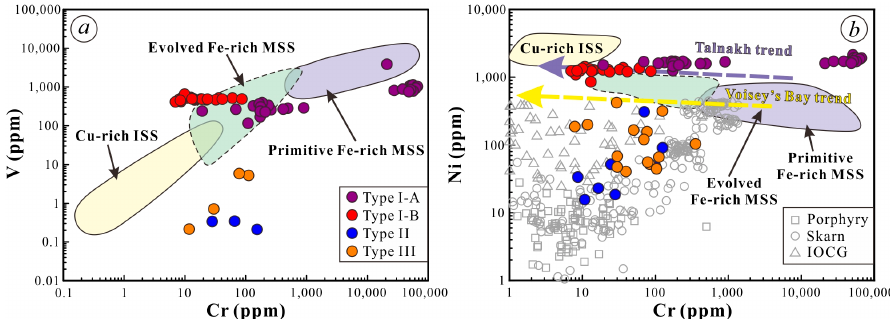
Figure 8. Plots of ( a ) V vs. Cr and ( b ) Ni vs. Cr for the Jinchuan different types of magnetite in massive and disseminated sulfide ores. Fields of primitive Fe-rich MSS, evolved Fe-rich MSS, and Cu-rich ISS areas are from [6]. The evolution trends of Talnakh and Voisey’s Bay are from [12]. Hydrothermal magnetite data from porphyry, skarn, and IOCG deposits and references are same as Figure 6.